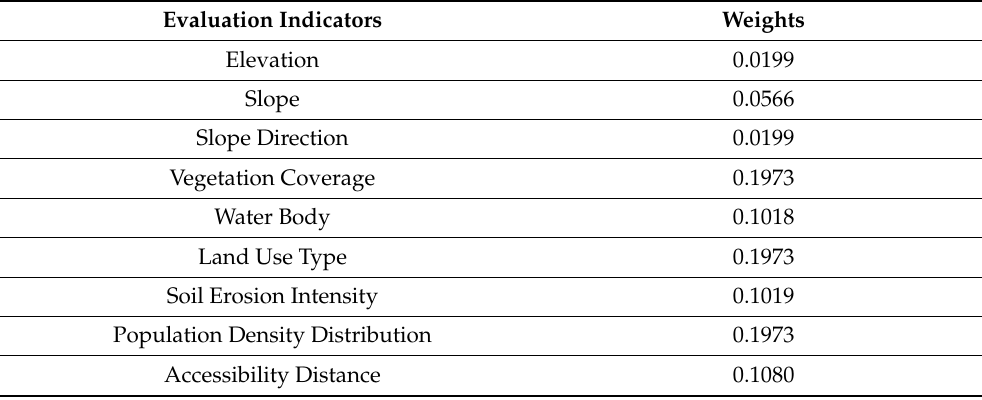
Table 1. Weight calculation results of different